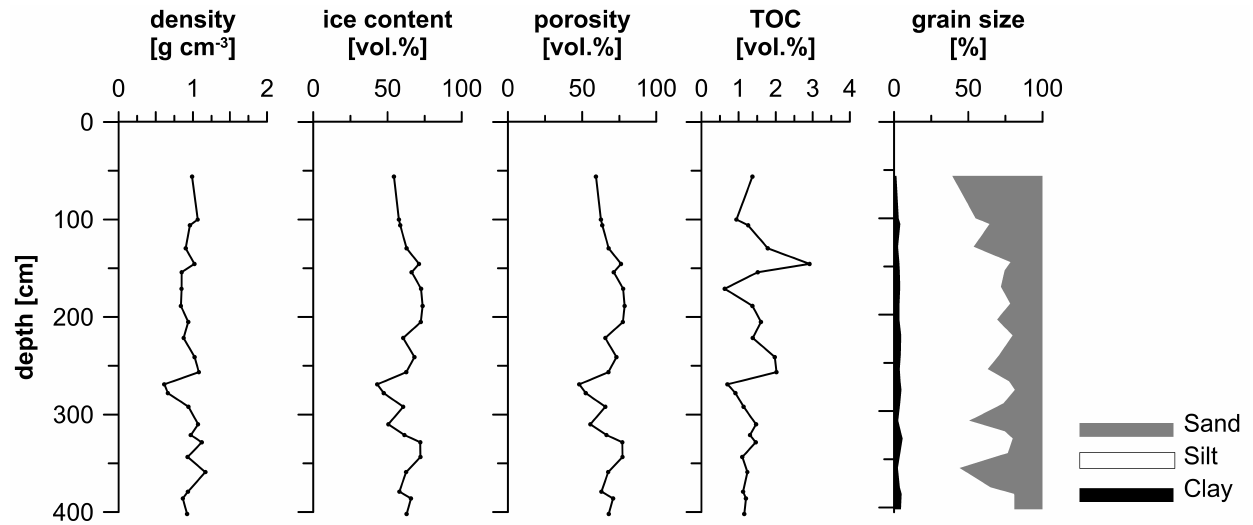
Fig. 5. Physical soil characteristics determined for a 4m core of frozen soil from Samoylov Island (close to lake 1; see Fig.